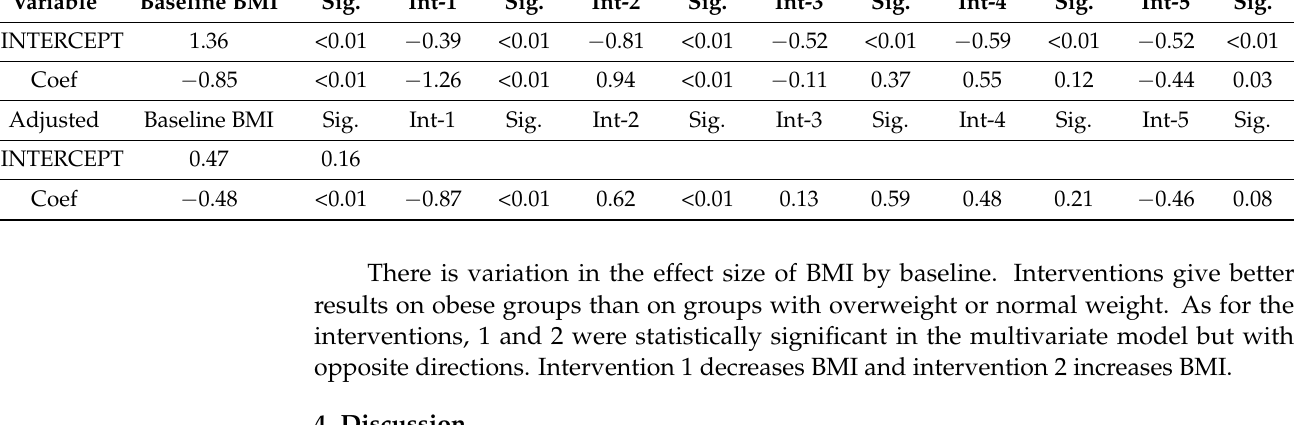
tors. Table 4 studies the effects of the five types of interventions and the baseline BMI. Table 4. Moderator analysis, adjusted meta-regression by the baseline of Body Mass Index and interventions.